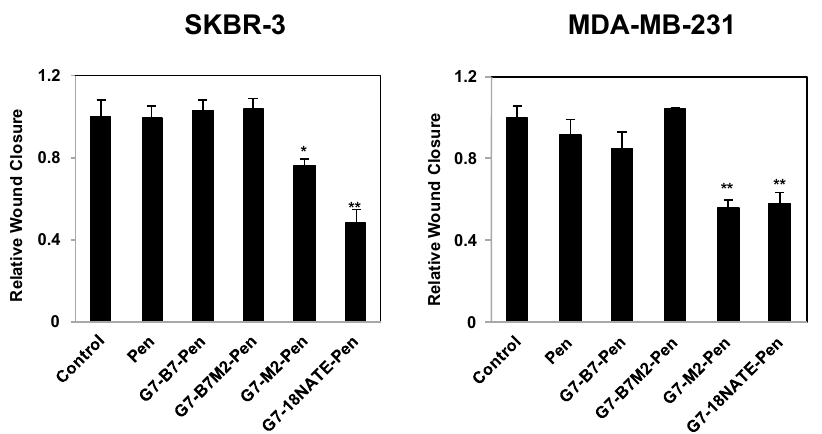
Figure 4. Effect of the G7-peptide inhibitors on ( left ) SKBR-3 and ( right ) MDA-MB-231 cell migration using wound healing assay. SKBR-3 and MDA-MB-231 cells were treated with 20 μ M of the control peptide (Pen) or 20 µ M G7-peptide inhibitors (G7-B7-Pen, G7-B7M2-Pen G7-M2-Pen and G7-18NATE-Pen). Cell migration was analyzed using the wound-healing assay, in which a scratch wound was introduced into a confluent monolayer of SKBR-3 or MDA-MB-231 cell lines and the extent of wound closure monitored after 48 h (SKBR-3) or 8 h (MDA-MB-231). Relative wound closure is expressed relative to the untreated control MDA-MB-231 and SKBR-3 cells, which is normalized to 1.0. Bars represent means ± SEM for at least three independent experiments with duplicates. A student’s t-test was performed between control (no peptide) and G7-peptide treated samples with * p < 0.05, ** p < 0.01.